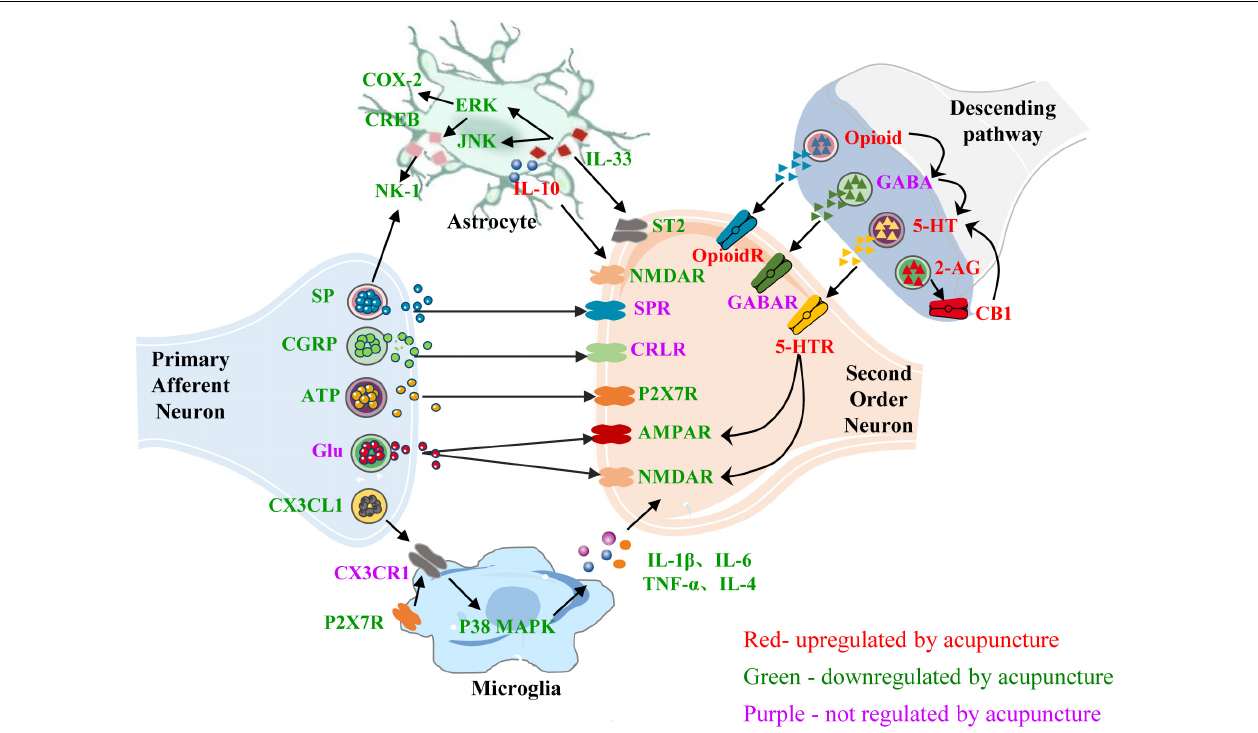
FIGURE 4 | Role of neuroimmune crosstalk within the central nervous system in mediating the anti-inflammatory and analgesic effects of acupuncture on inflammatory pain. The names of neurotransmitters, neuropeptides, and immune factors are presented in red, green, and purple, respectively. The factors in red are up-regulated by acupuncture, while those in green are down-regulated by acupuncture. The factors in purple are not regulated by acupuncture. SP, substance P; SPR, substance P receptor; NK1, neurokinin-1; CGRP, calcitonin-gene-related peptide; CRLR, calcitonin-gene-related peptide receptor; ATP, adenosine triphosphate; P2 × 7R, purinergic P2 × 7 receptor; CX3CL1, C-X3-C motif chemokine ligand 1; CX3CR1, C-X3-C chemokine receptor 1; p38 MARK, p38-mitogen-activated protein kinase; COX-2, cyclo-oxygen-ase 2; CREB, cAMP response element binding protein; ERK, extracellular signal-regulated kinases; JNK, c-Jun-N-terminal kinase; AMPAR, α -amino-3-hydroxy-5-methyl-4- isoxazolepropionic acid receptor; NMDAR, N-methyl- D -aspartate receptor; GABA, γ -aminobutyrate; 5-HT, 5-hydroxytryptamine; 5-HTR, 5-hydroxytryptamine receptor; CB1, cannabinoid 1; CB1R, cannabinoid receptor 1; OpioidR, opioid receptor; GABA, γ -aminobutyrate; GABAR, γ -aminobutyrate receptor; 2-AG, 2-arachidonoyl glycerol; IL-1 β /4/6/10, interleukin-1 β /4/6/10; TNF- α , tumor necrosis factor- α